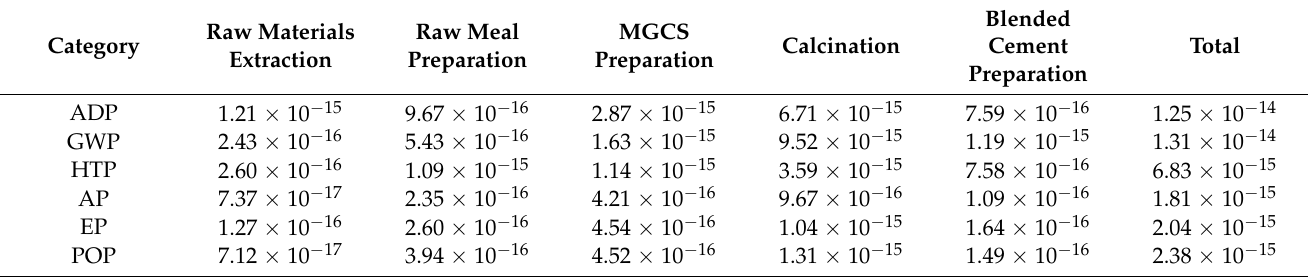
Table 3. Contribution of each stage on selected impact categories